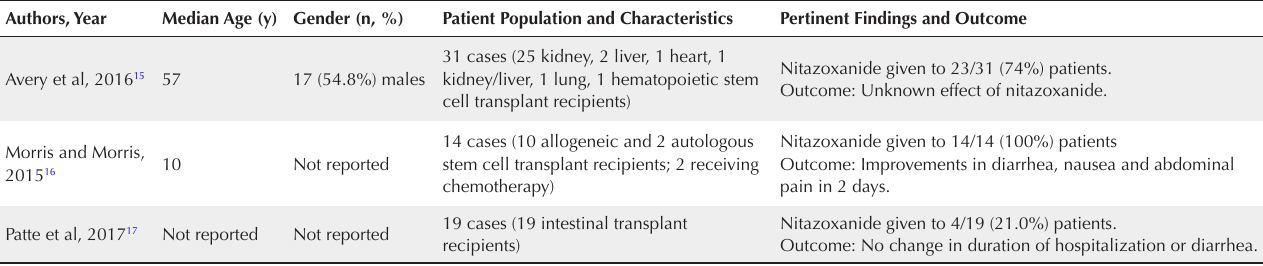
Table 2. Case Series on Nitazoxanide for Viral Gastroenteritis Due to Norovirus Authors, Year Patient Population and Characteristics Pertinent Findings and Outcome